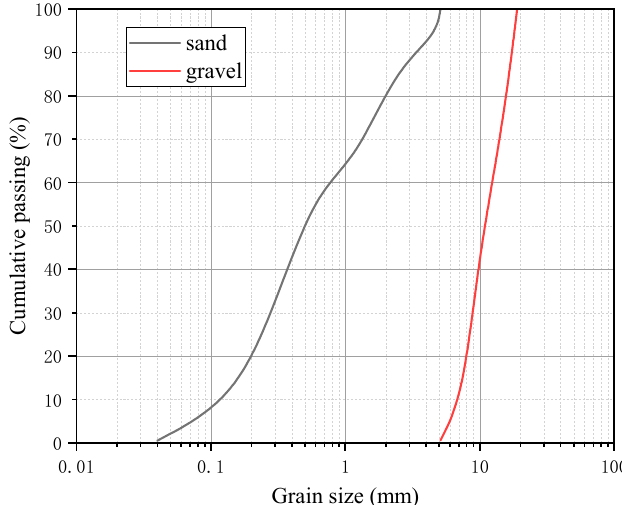
Table 1. Details of concrete mixture.